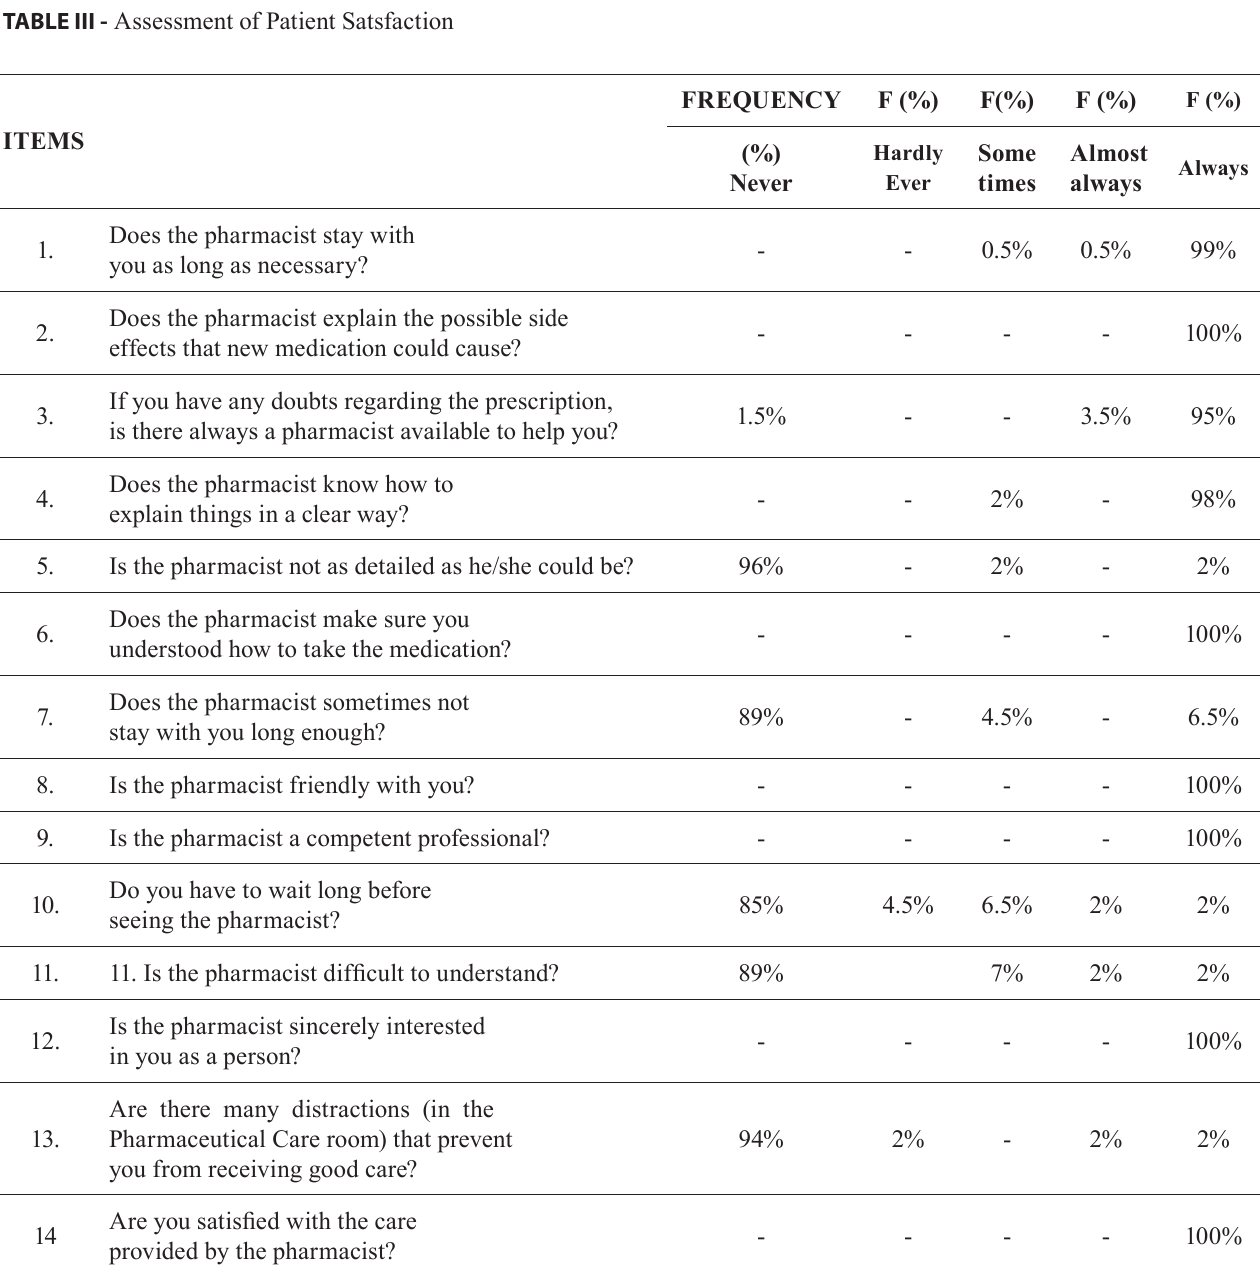
TABLE III - Assessment of Patient Satsfaction